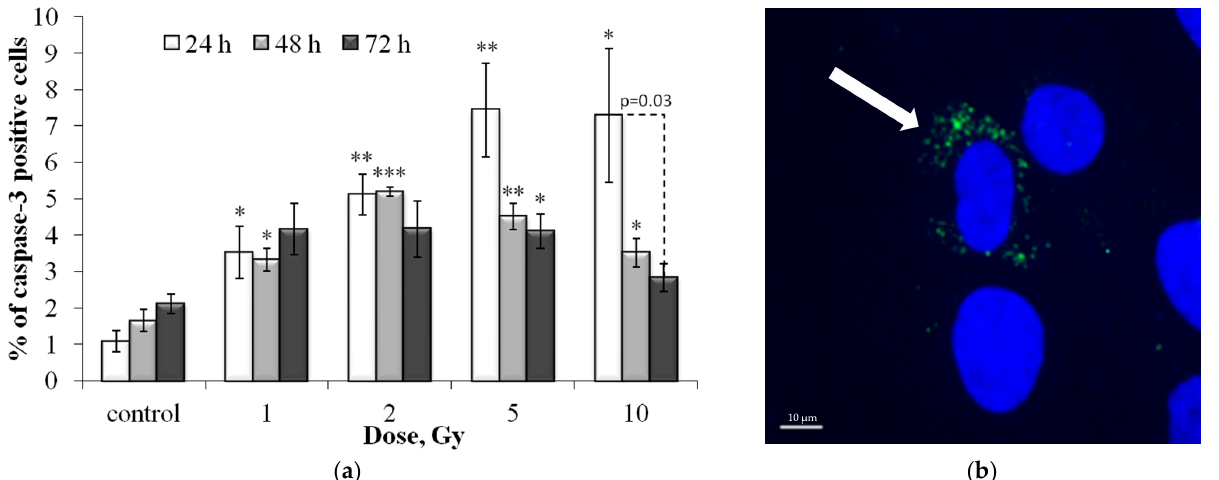
( b ) Figure 9. ( a ) Dose-dependent changes in the LC3-II positive cell fraction in human fibroblasts 24 h, 48 h and 72 h after irradiation. Data are means ± SE of three independent experiments. * p < 0.05 and ** p < 0.01—compared with the corresponding time of control; ( b ) Representative microphotograph of the immunocytochemically labeled с ells with LC3-II (LC3-II positive cell with punctate LC3-II (green) is marked with the arrow). Nuclei are counterstained with DAPI (blue). 3.6. Dose and Post-Irradiation Time-Dependent Changes in the Caspase-3 Positive Cell Fraction Effector caspase-3, belonging to the family of cysteine-aspartate proteases (caspase), is widely known primarily due to its important role in the process of cell death through apoptosis [32]. However, the functions of caspase-3 are much wider, in particular, it is important for the regulation of autophagy processes [33] and the balance between the processes of cell death and aging [34]. According to recent data, caspase-3 cleavage of specific target proteins also regulates cell cycle progression, differentiation, and tumor- igenesis [35]. Therefore, it was important to study changes in the proportion of caspase-3 positive cells in populations of irradiated fibroblasts. As can be seen from the results presented in Figure 10, a dose-dependent increase in